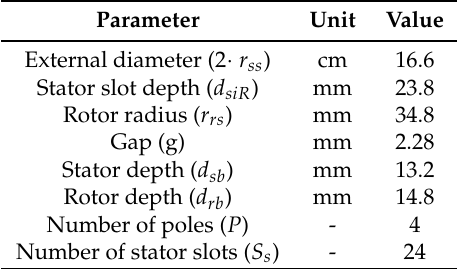
Table 1. Geometric characteristics of the machine